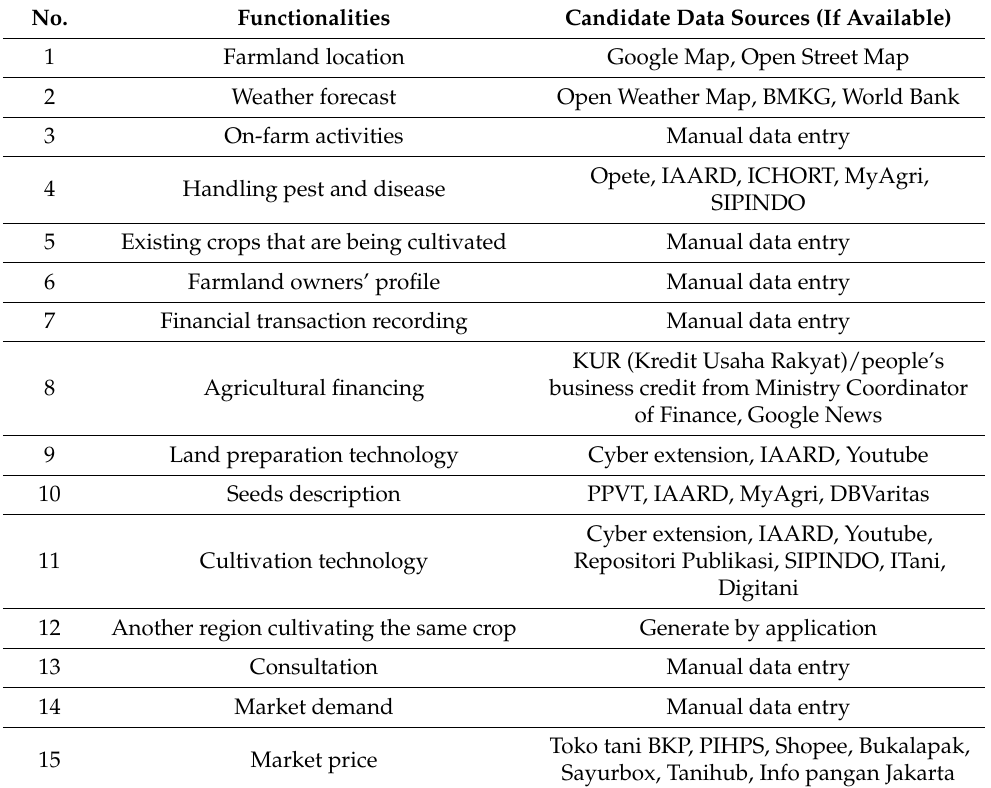
Table A2. Candidate Data Sources for Each Small Farm Management Information System (sFMIS)